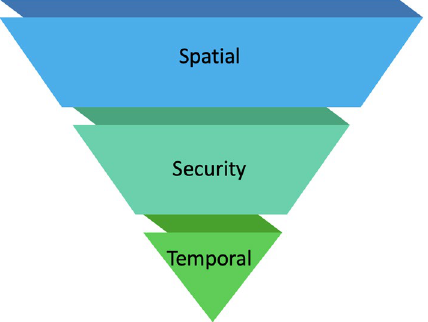
Figure 3. There is a hierarchy of data modality features that influence people’s privacy preferences in smart buildings. Spatial context is the most influential, with decreasing influence from top to